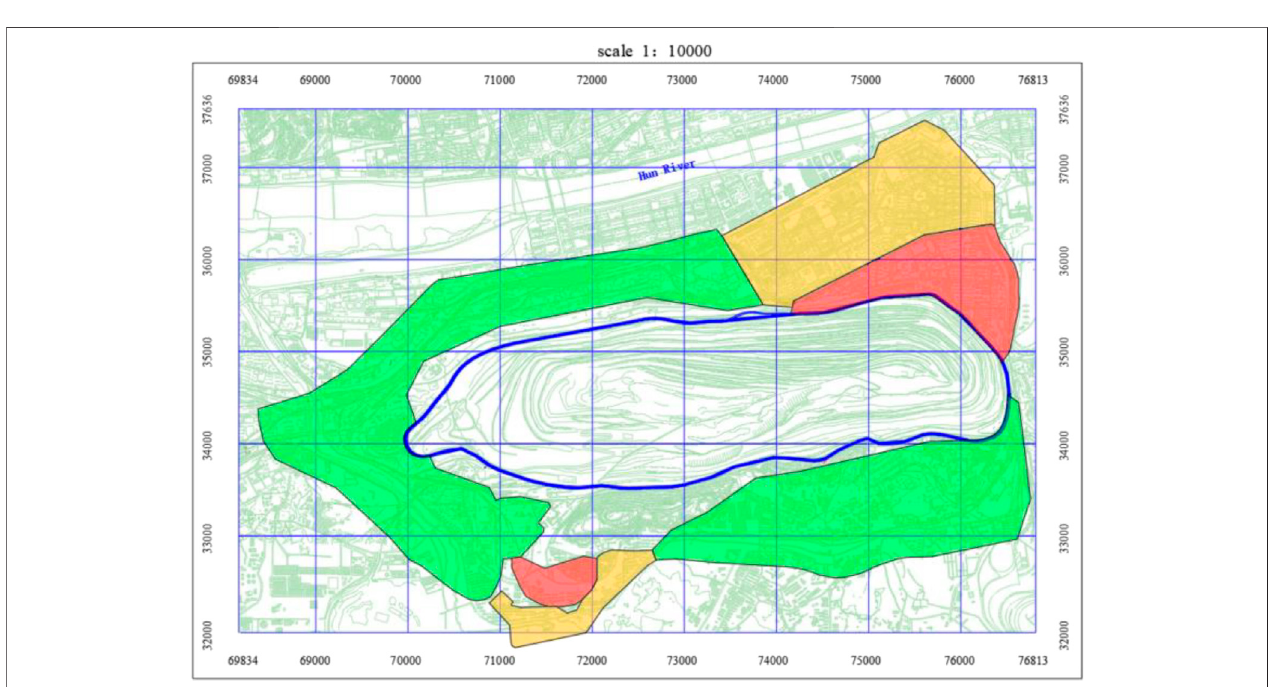
FIGURE 17 | Emergency forti fi cation zoning of slope disasters in the affected area.